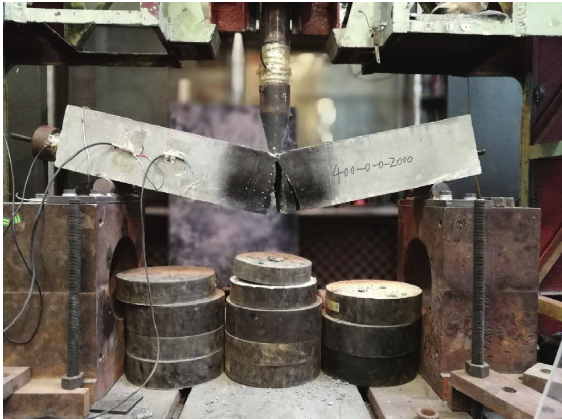
Figure 4: Typical deformation and failure characteristics of samples under impact load.